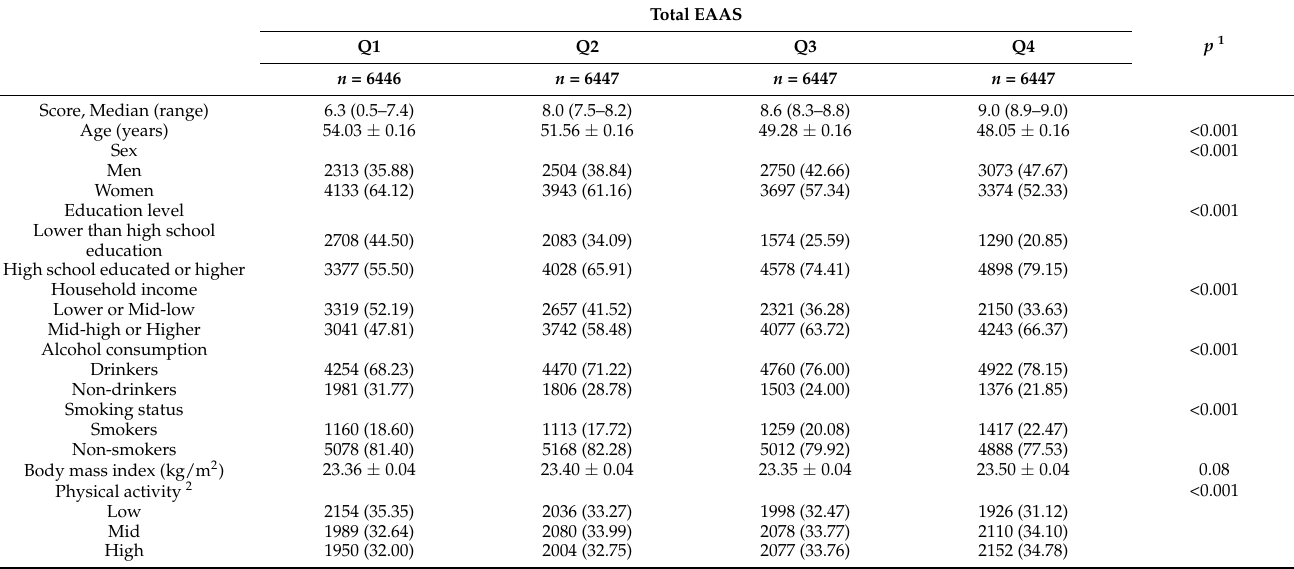
Table 1. General characteristics of the participants according to quartile of total EAAS, KNHANES 2008–2019 ( n = 25,787). Total